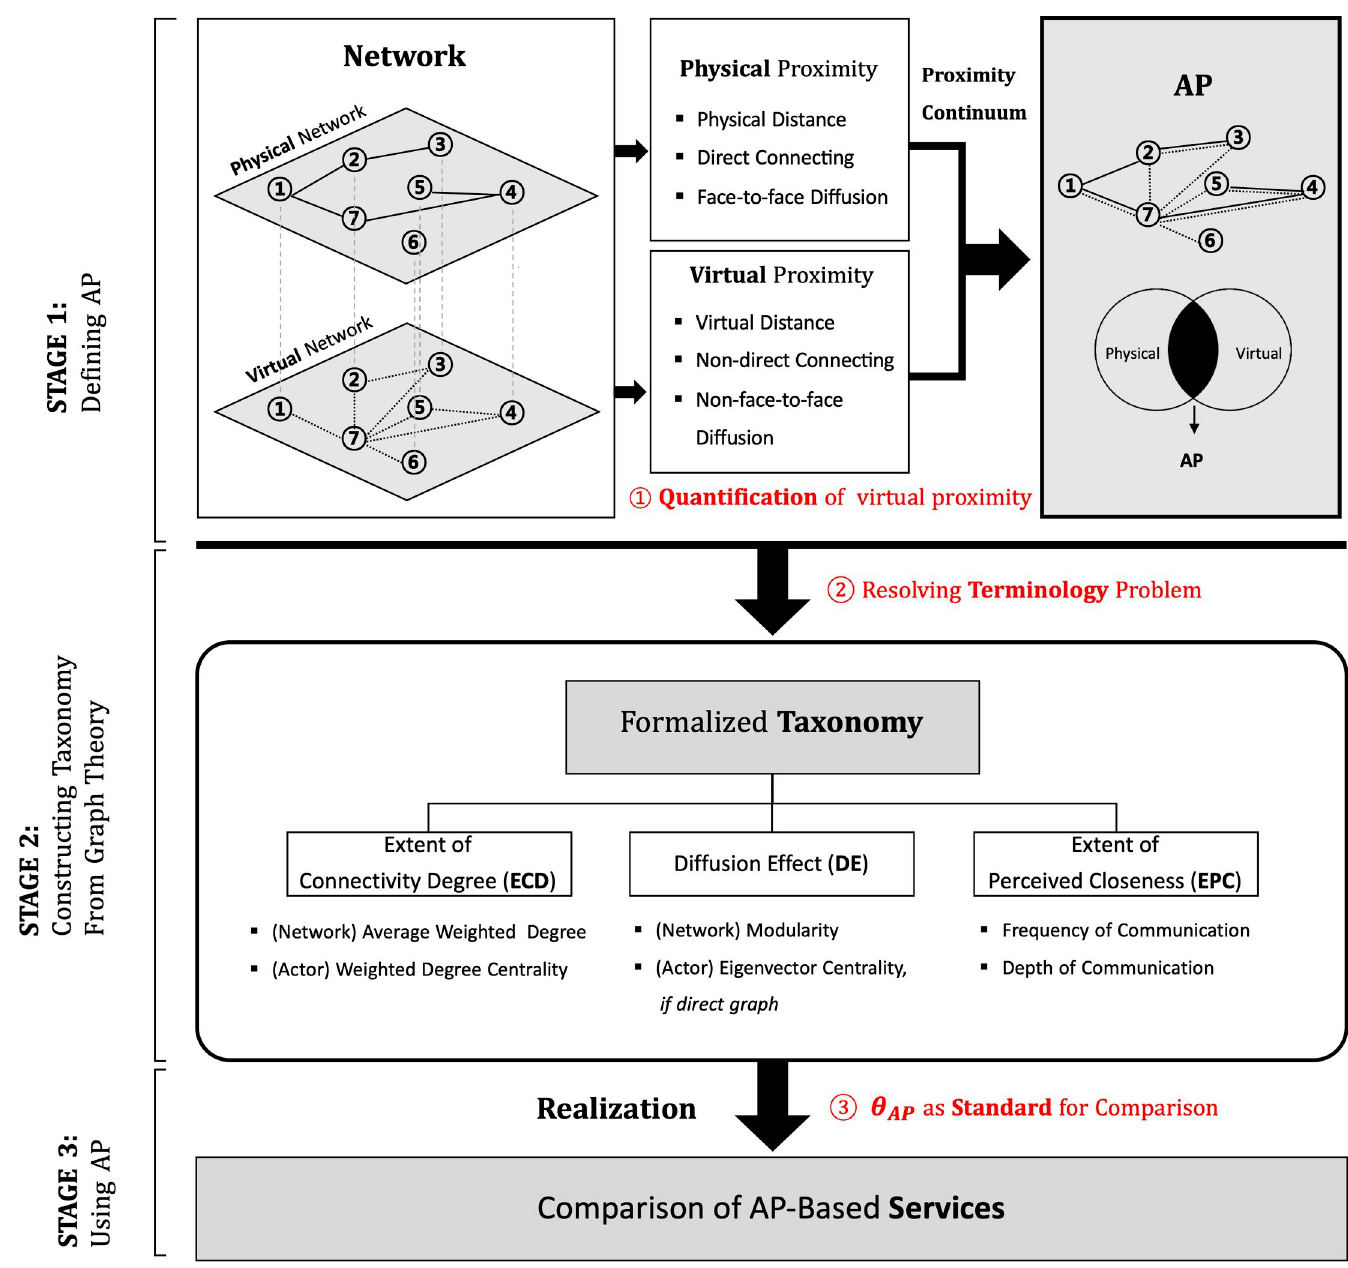
Fig 1. Three-stage process for defining augmented proximity